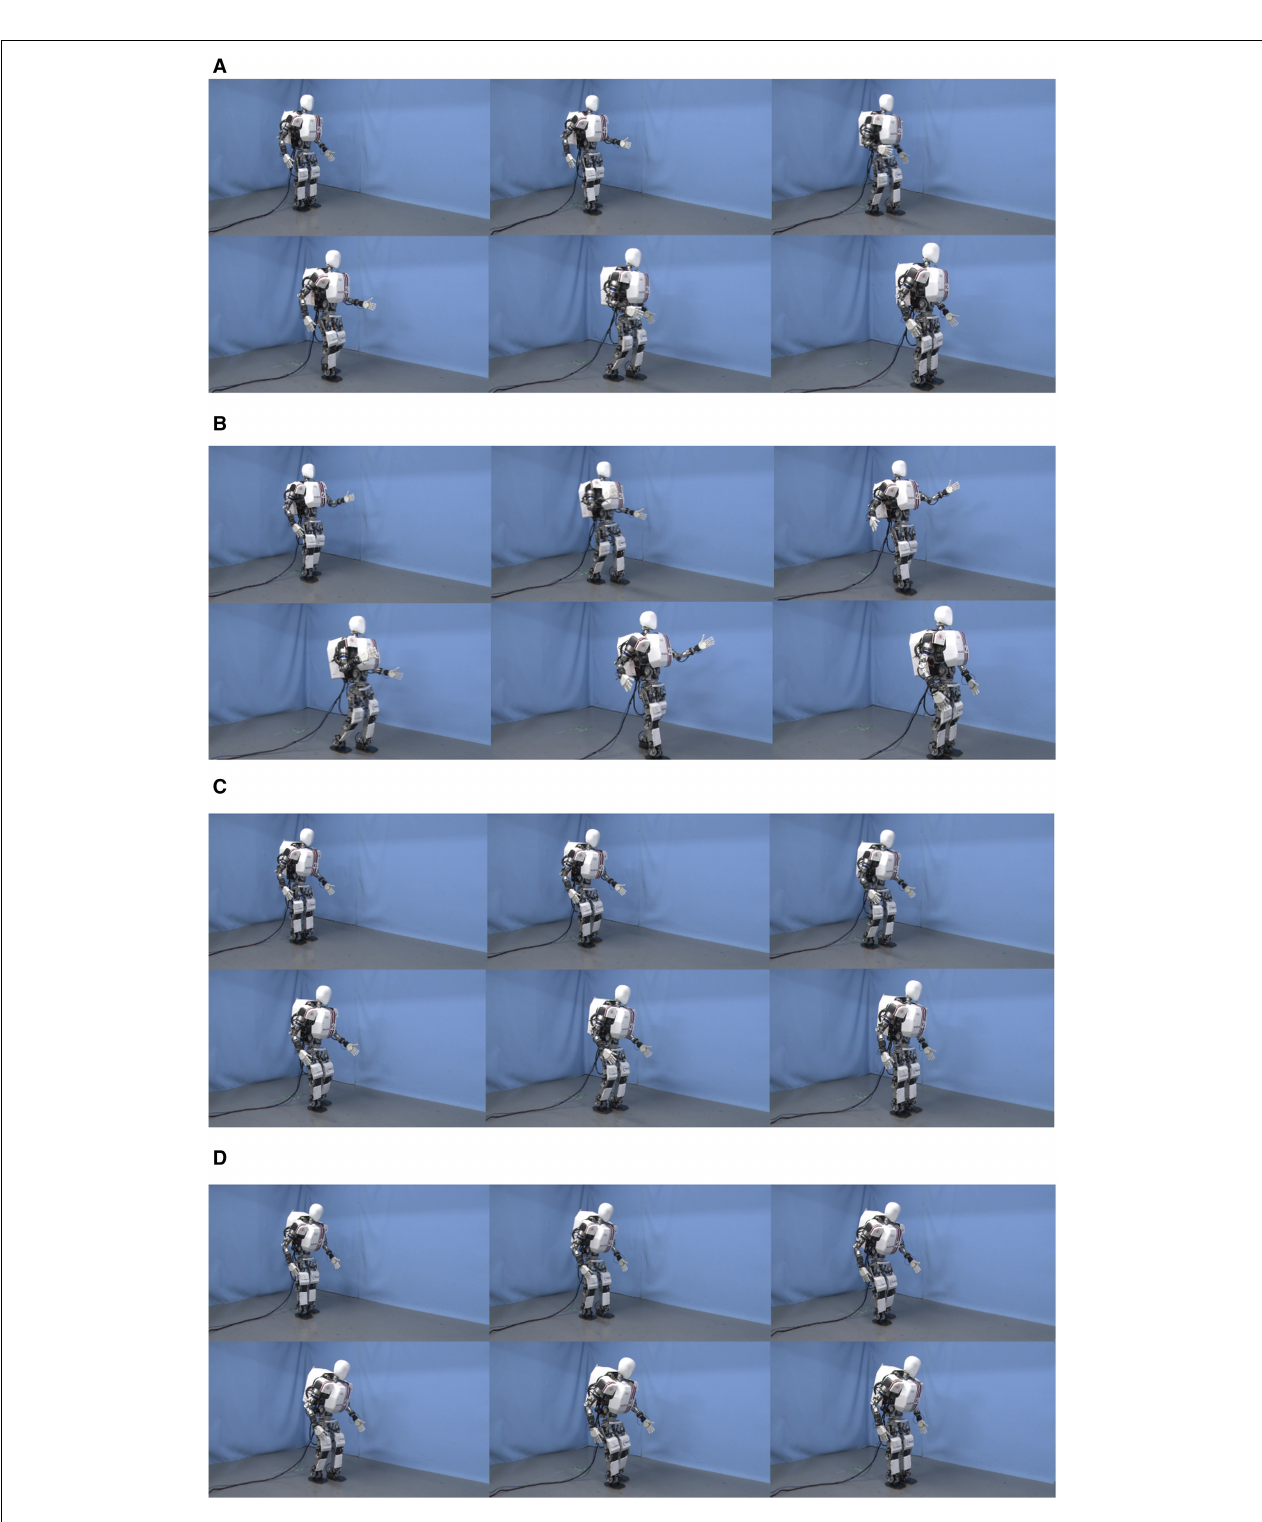
FIGURE 3 | Emotional gait patterns. The following images are captured from the videos shown to the participants. (A) represents Happy walk (Natural intensity); (B) Happy walk (Exaggerated intensity); (C) Sadness (Natural intensity); (D) Sad walk (Exaggerated intensity).